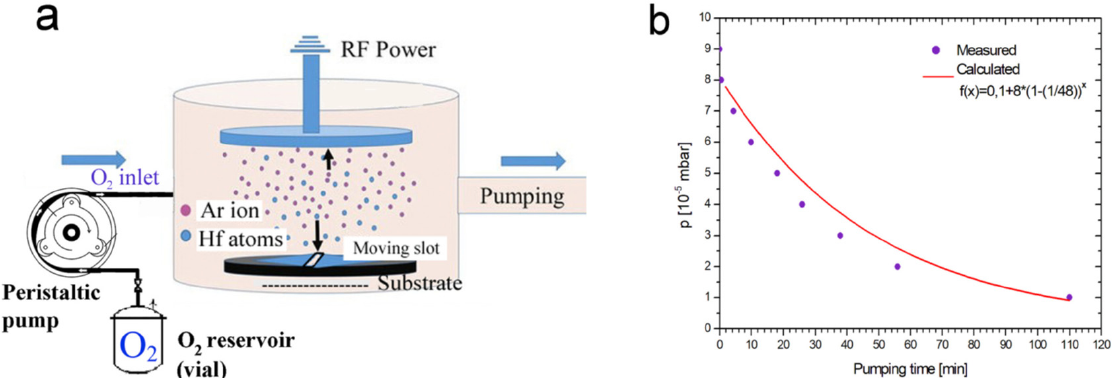
Figure 14. ( a ) Setup of a self ‐ regulating gas injection system that consists of a vial connected to a peristaltic pump. ( b ) Variation in oxygen partial pressure vs. time in the sputtering chamber achieved by the self ‐ regulating gas inlet. The peristaltic pump was operated at a constant rate of 1 sccm emptying the 48 cm 3 vial of 1 bar of initial pressure. Full circles: measured pressure decay. Solid line: calculated pressure decay. Reproduced with permission from [63]. Copyright © 2020,